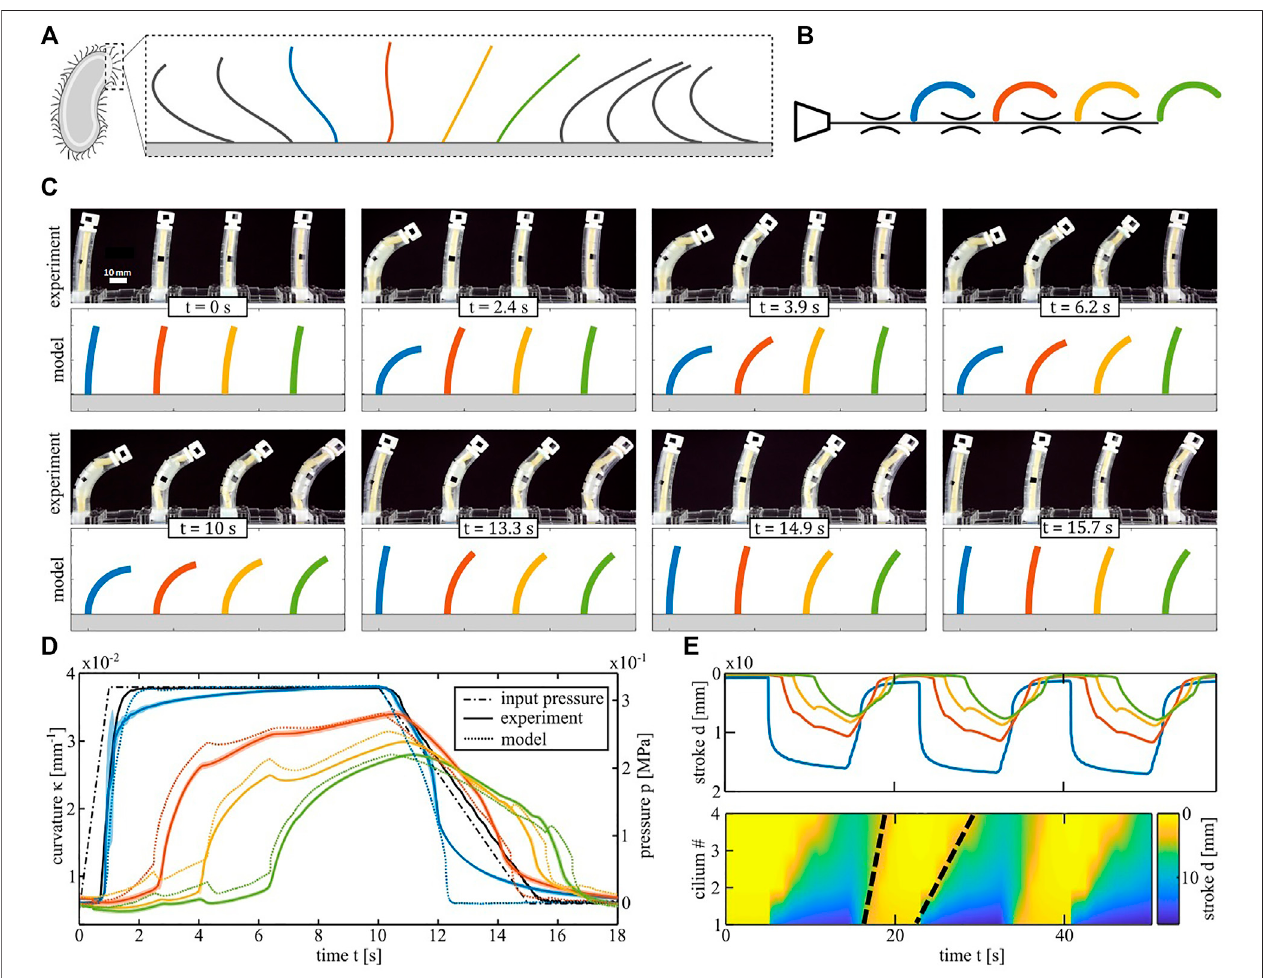
FIGURE 4 | Metachronal wave demonstrator. (A) Sketch of the metachronal wave in a biological cilia array. (B) Schematic of the equivalent fl uidic model of the arti fi cial cilia array. The color code is different from the one of the spatial asymmetry test. Here the four actuators are the same type NMl. (C) Arti fi cial cilia array con fi guration at different instantsofacycle.Snapshotsfrom theexperiment are compared withsimulated curvaturesoftheequivalentmodel. (D) Curvature response of the four cilia during one period following the pressure input(black line). Experimental results are averaged over fi ve cycles. The mean isplotted in solidlinesand the coloured areas represent the standard deviation in pressure. Dotted lines are the output of the fl uidic circuit analysis. (E) Spatiotemporal graphs (kymographs) of the tip vertical displacement of the four cilia. Zero displacement is depicted in yellow and the maximum in blue. The Black dashed lines track the wavefront of the metachronal wave and their slope represents the wave